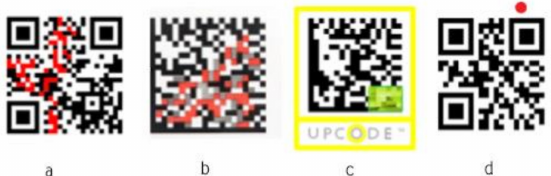
Figure 10. Types of sensors encoding in the SmartTag: ( a ) encoding inside the QR code matrix with one ink; ( b ) encoding multiple types of functional ink (grey and red); ( c ) encoding sensor (green) as a part